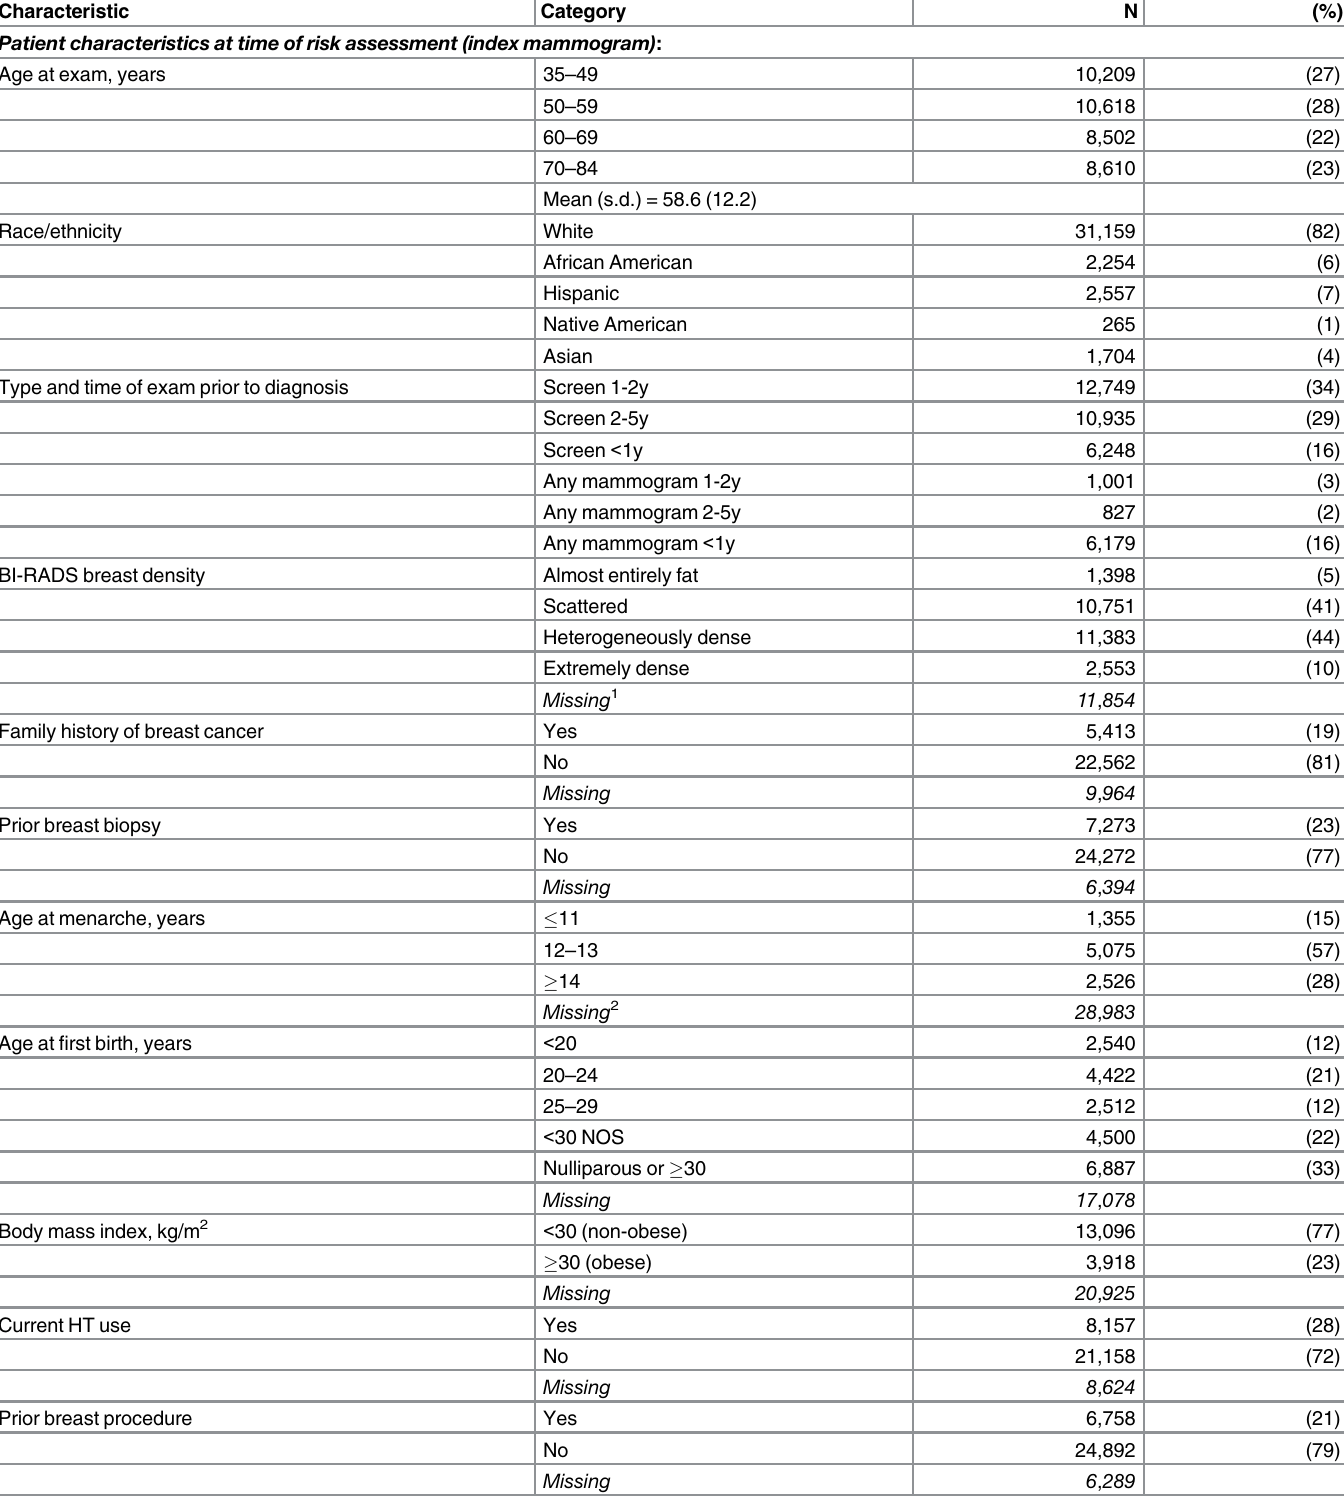
Table 1. Characteristics of 37,939 Women with Breast